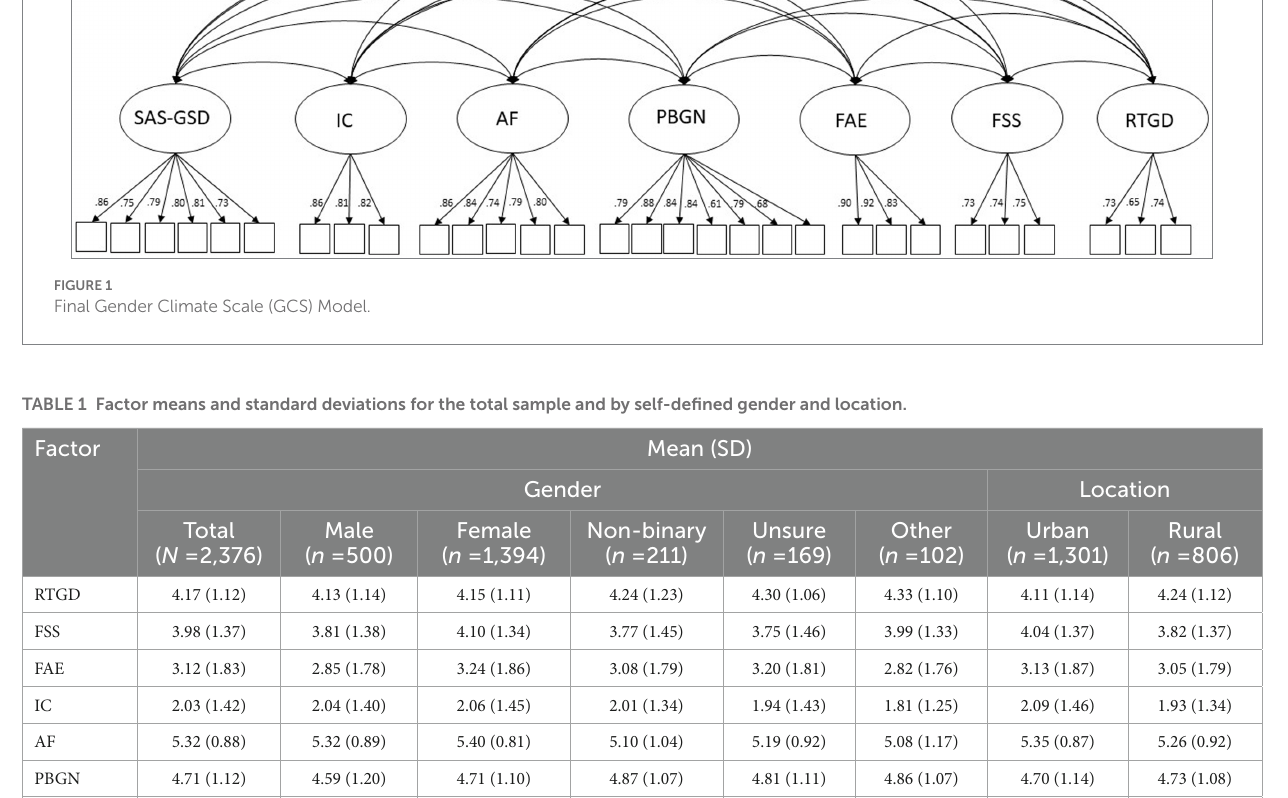
RTGD, Reinforcement of Traditional Gender Difference; FSS, Freedom of Subject Selection; FAE, Freedom of Appearance Expression; IC, Inclusive Health and Physical Education Curriculum; AF, Academic fairness; PBGN, Popularity Based on Gender Norms; and SAS-GSD, School’s Acceptance and Support of Gender and Sexuality Diversity.